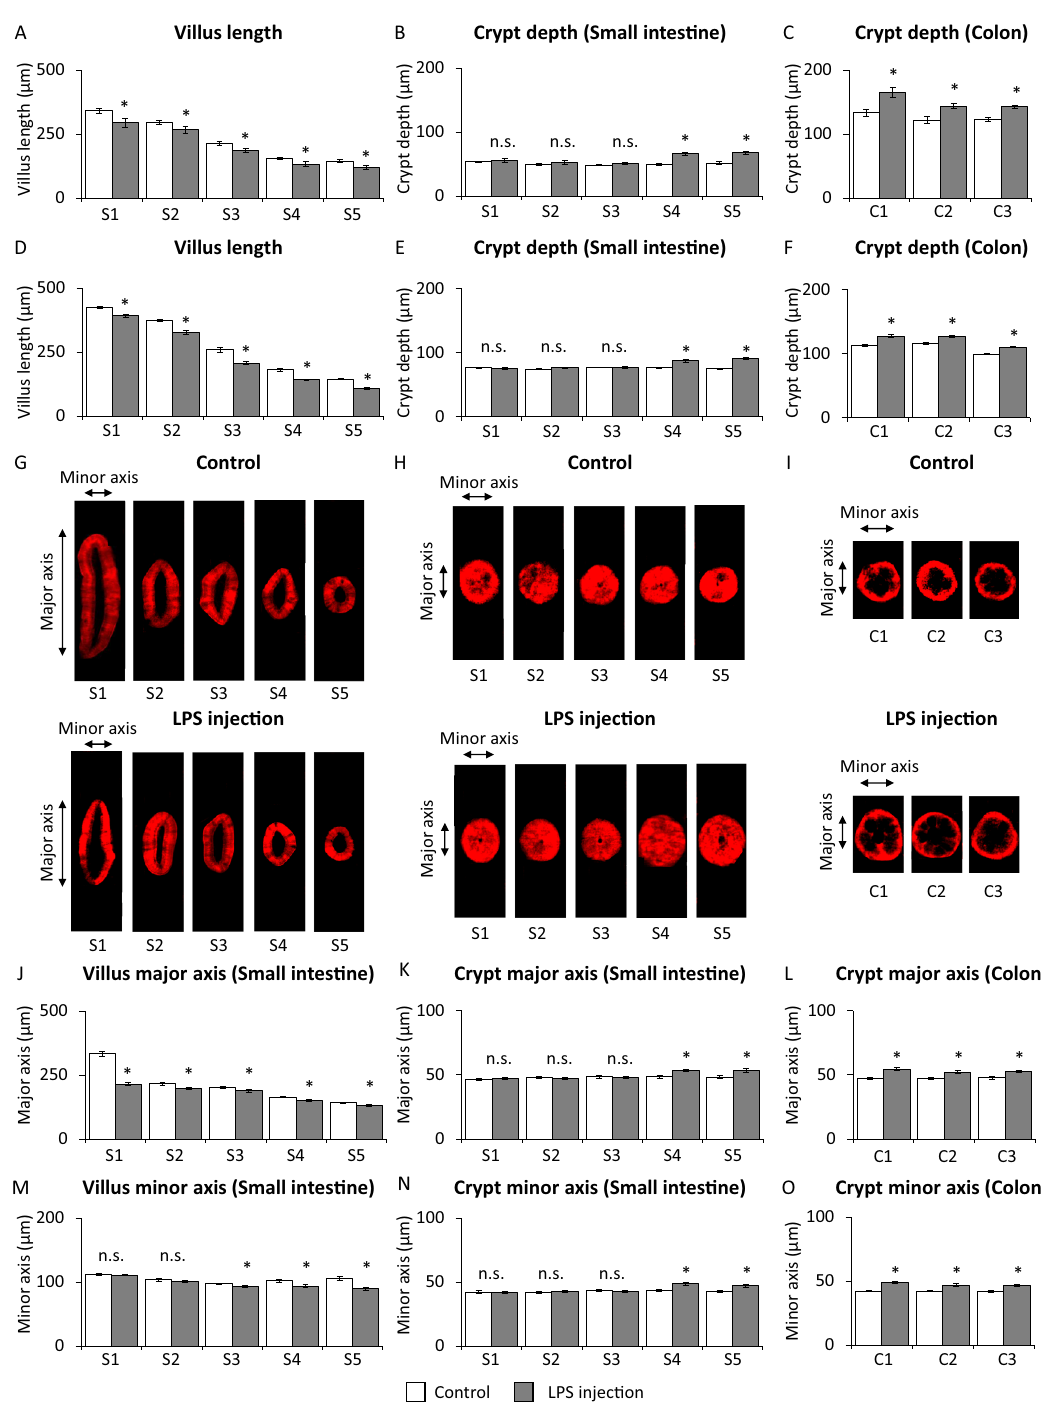
Figure 4. Morphology and analysis of the small intestine and colon in LPS-injected Villin1-Tomato mice. ( A ) Villus length, ( B ) crypt depth of small intestine, and ( C ) crypt depth of colon analyzed by 2-D imaging in control mice (White bar) and LPS-injected mice (Gray bar) (n = 30 villi or 30 crypts in 3 mice). ( D ) Villus length, ( E ) crypt depth of small intestine, and ( F ) crypt depth of colon analyzed by 3-D imaging in control mice (White bar) and LPS-injected mice (Gray bar) (n = 50 villi or 50 crypts in 5 mice). Cross sectional images of ( G ) villus and ( H ) crypt in small intestine and ( I ) crypt in colon of control mice and LPS-injected mice. Width of villus ( J ) major and ( M ) minor axis, of crypt ( K ) major and ( N ) minor axis of small intestine and of crypt ( L ) major and ( O ) minor axis of colon evaluated by 3-D imaging in control mice (White bar) and LPS-injected mice (n = 50 villi or 50 crypts in 5 mice). *P < 0.05 vs. control mice, n.s. not